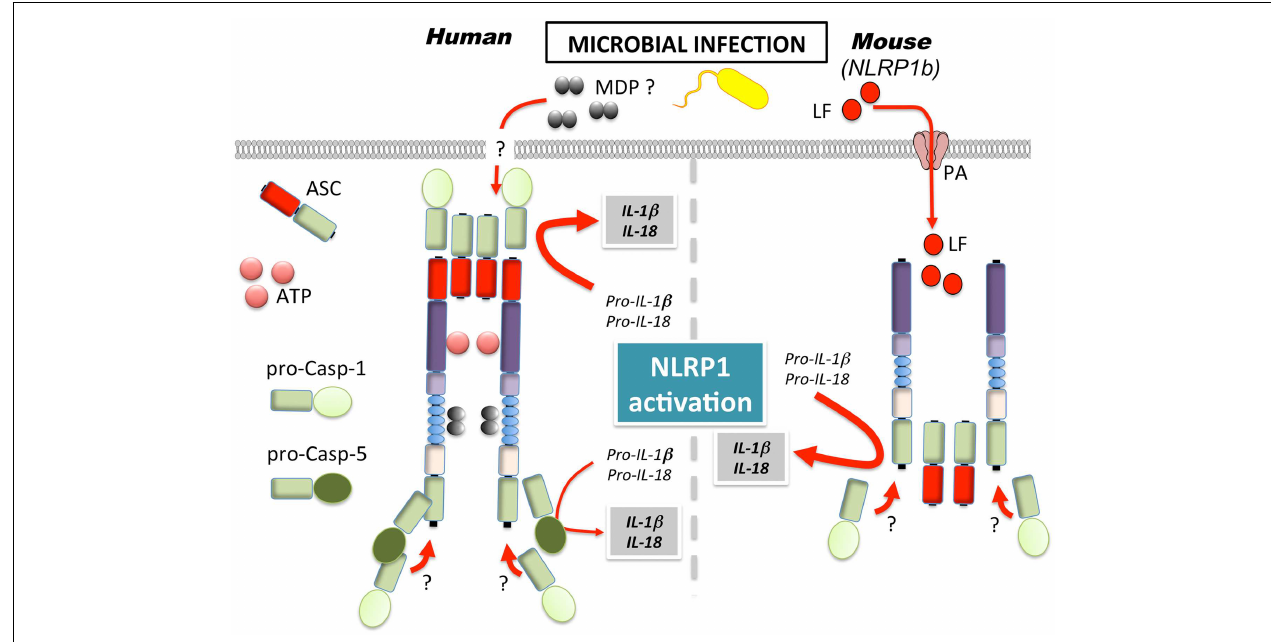
FIGURE 2 | Mechanism of NLRP1 activation in human and mice . MDP, muramyl dipeptide; LF, lethal factor; PA, protective